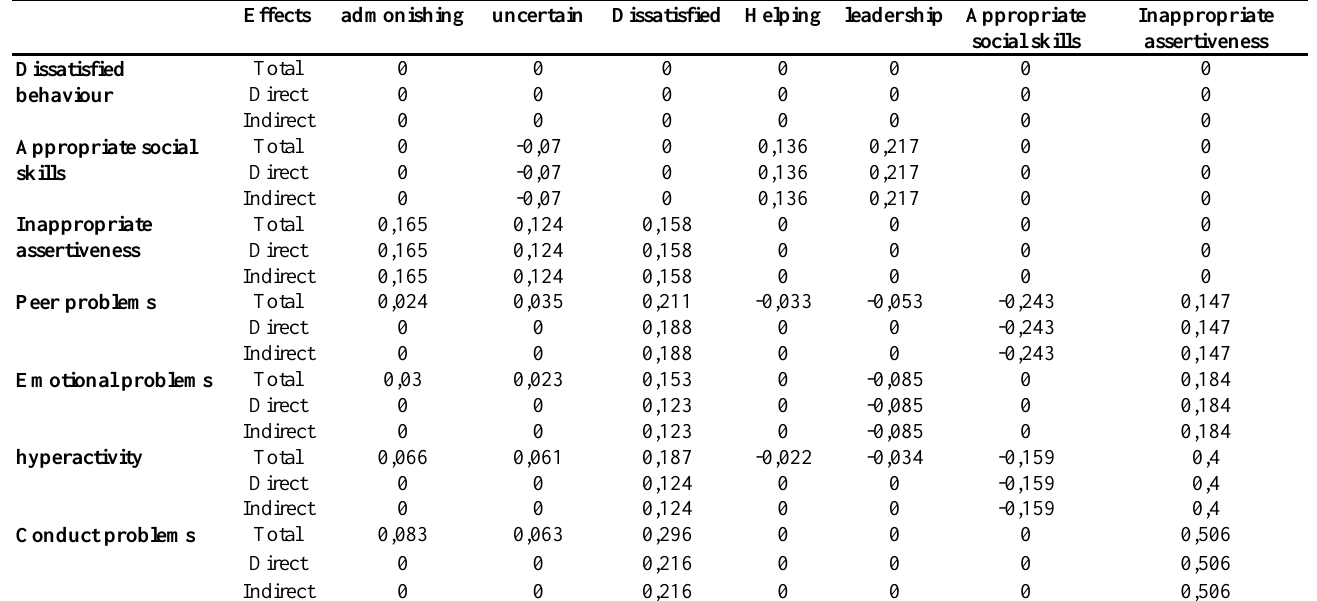
Standardized effects (Direct, Indirect,